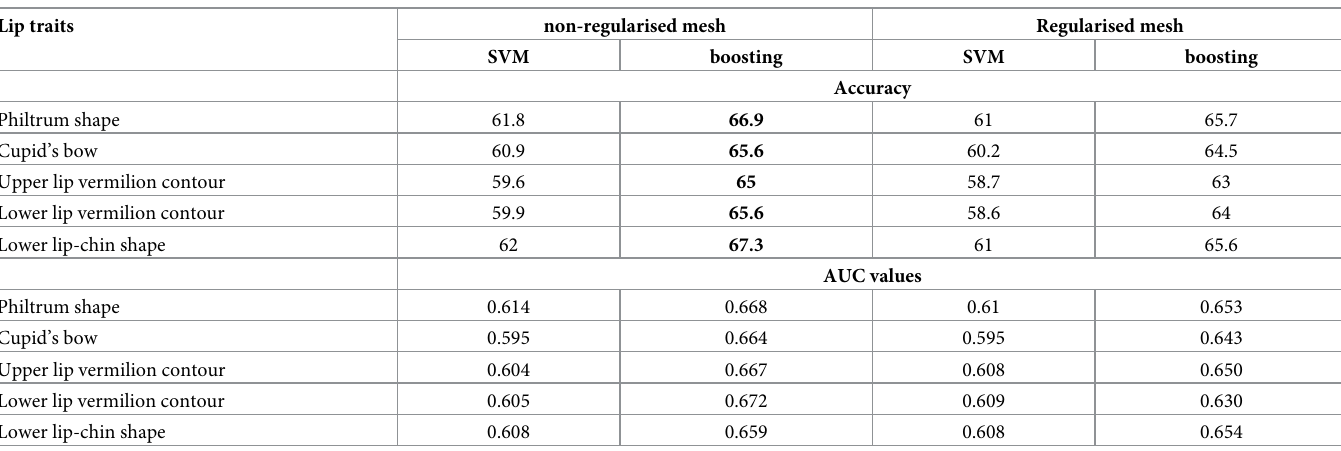
Table 4. Classification results based on geodesic distance.